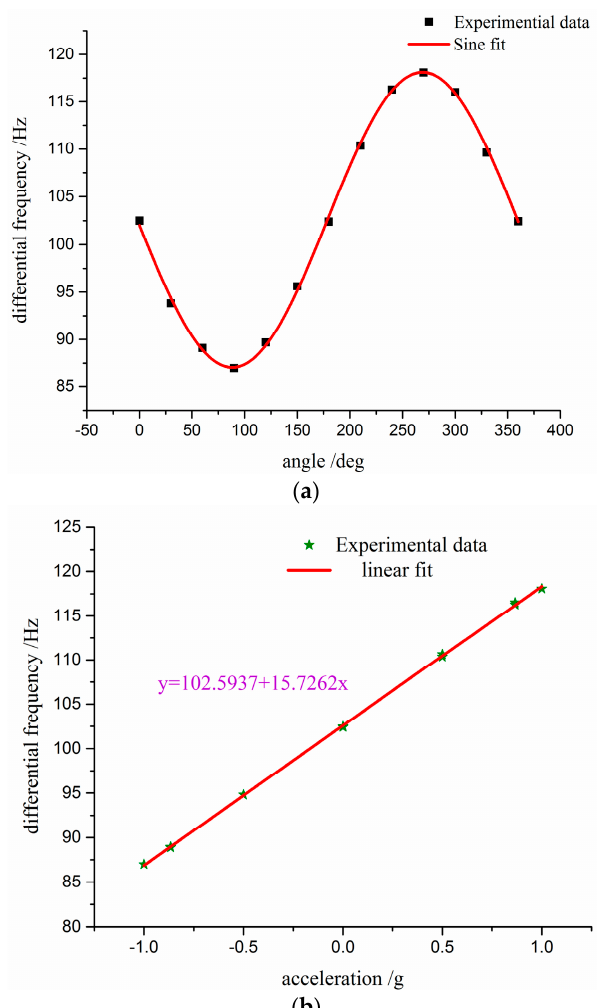
Figure 18. Tumble testing with a precise dividing head: ( a ) differential frequency shift versus rotating angle; and ( b ) differential frequency shift versus applied acceleration.